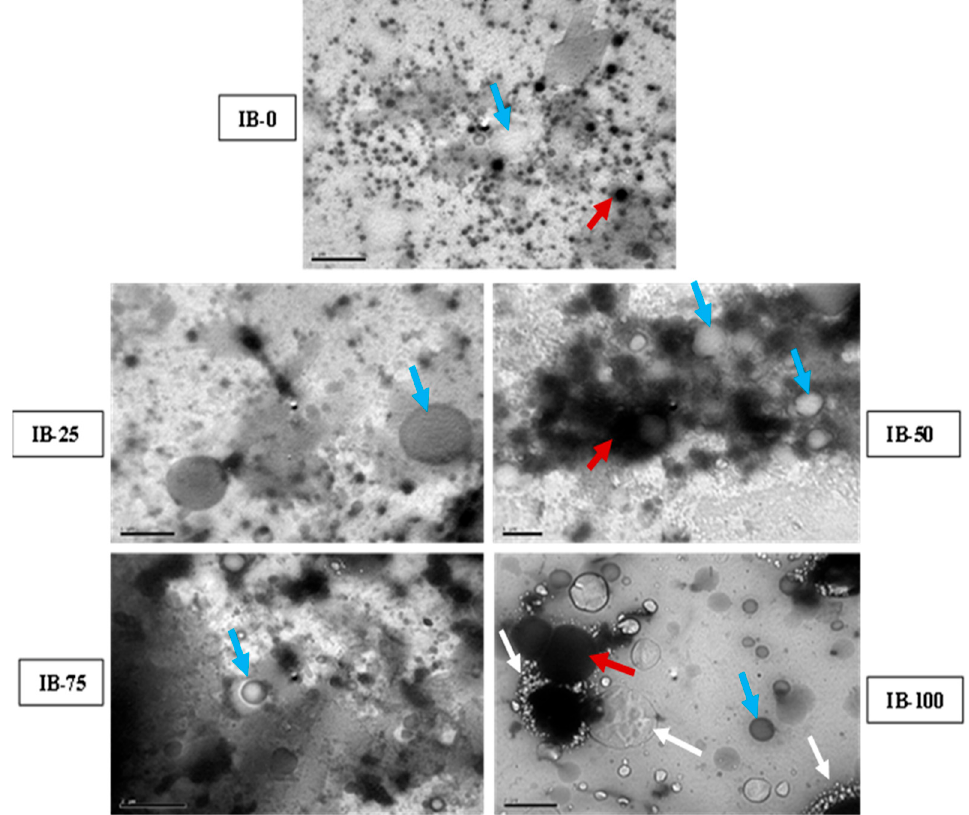
Figure 3. Transmission electron micrographs (1 µm bar) of ice cream samples in ice cream incorporating ADFP. Protein clusters (red arrow), fat globules (blue arrow), and water separation (white arrow). IB-0: control ice cream, IB-25: ice cream with 25% of its skimmed milk content partially replaced with ADFP, IB-50: ice cream with 50% of its skimmed milk content partially replaced with ADFP, IB-75: ice cream with 75% of its skimmed milk content partially replaced with ADFP, IB-100: ice cream with its skimmed milk content replaced with ADFP.